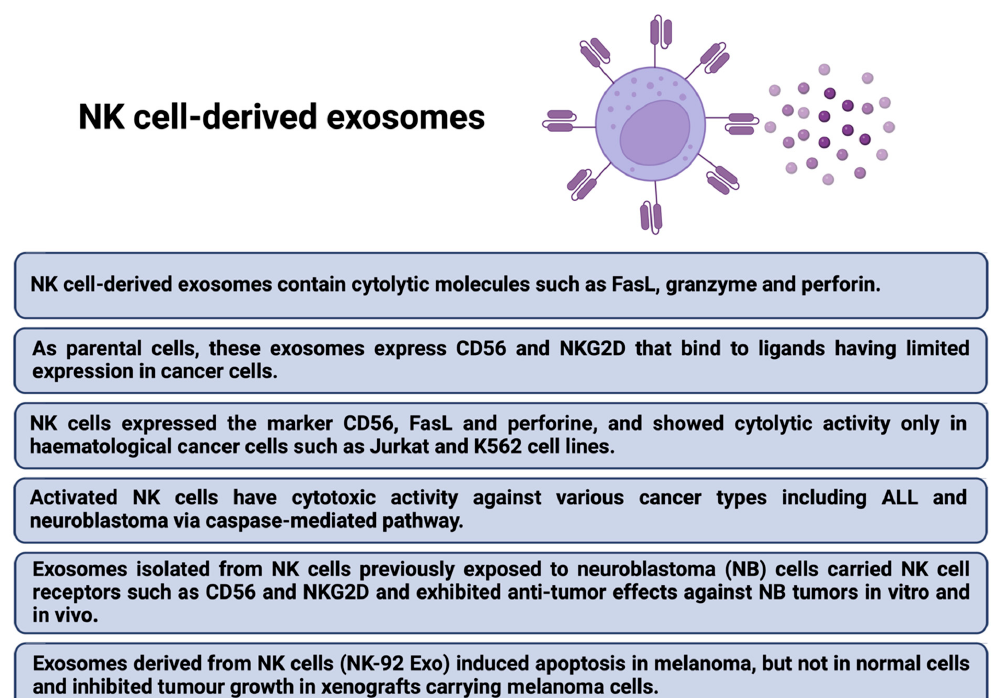
Figure 8. The features of NK ‐ cell derived exosomes [147–151].